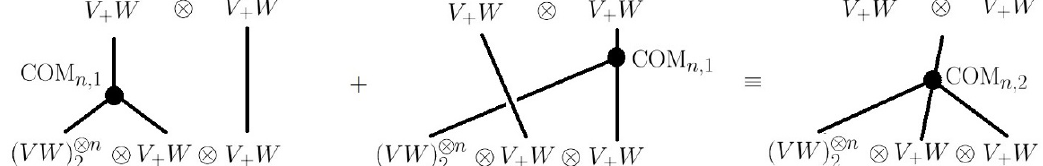
Figure 4 . De(cid:12)nition of COM n; 2